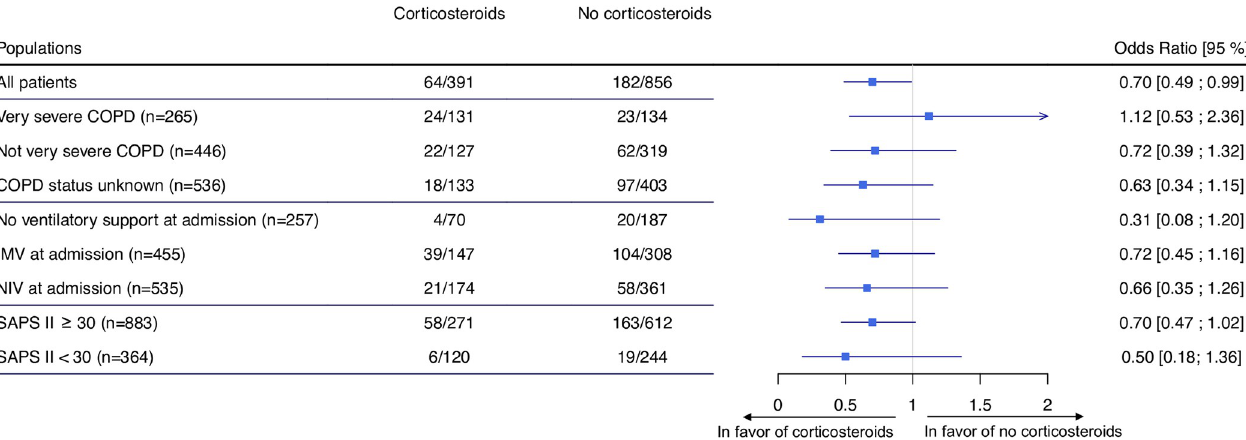
Fig 2. Summary of results for the primary outcome (death or invasive mechanical ventilation at day 28). Heterogeneity for COPD severity subgroups: Chi 2 = 3.50, df = 2, p = 0.32. Heterogeneity for ventilatory support subgroups: Chi 2 = 6.36, df = 2, p = 0.10. Heterogeneity for SAPS II subgroups: Chi 2 = 5,26, df = 1, p = 0.15. COPD : Chronic obstructive pulmonary disease . NIV : Non-Invasive Ventilation . IMV : Invasive Mechanical Ventilation . SAPS II : The Simplified Acute Physiology Score II .